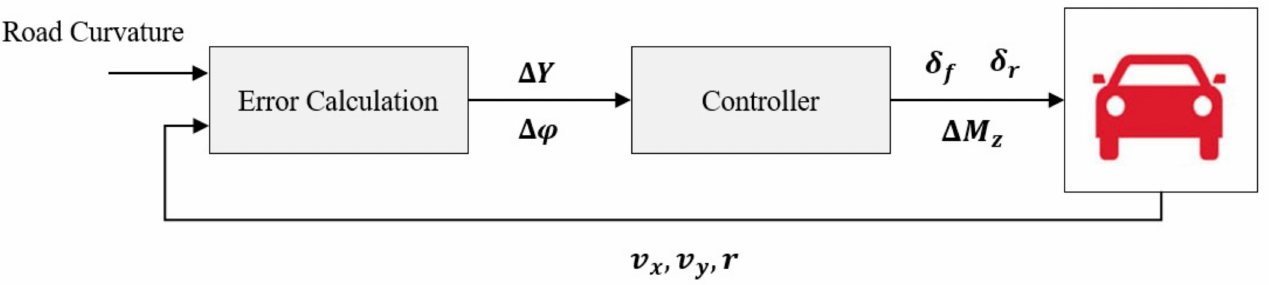
Figure 11. Control diagram of the integrated 4WS + DYC control system in